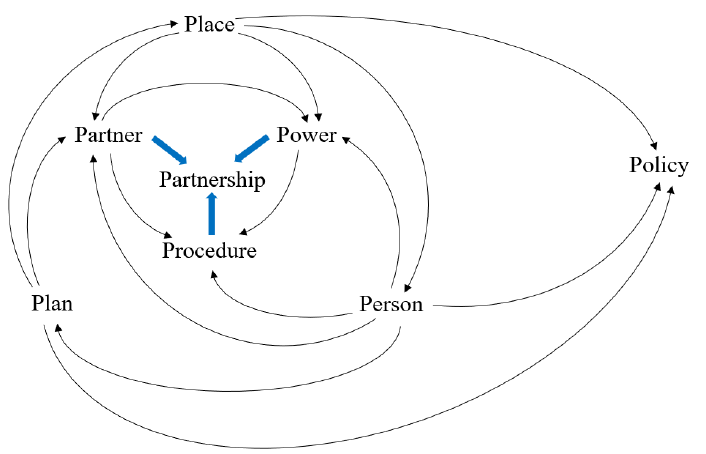
Figure 7. The connection among the “8p”.